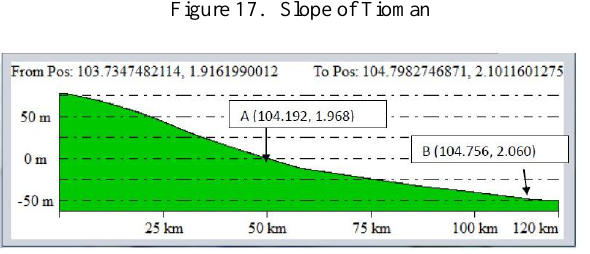
Figure 17. Slope of Tioman